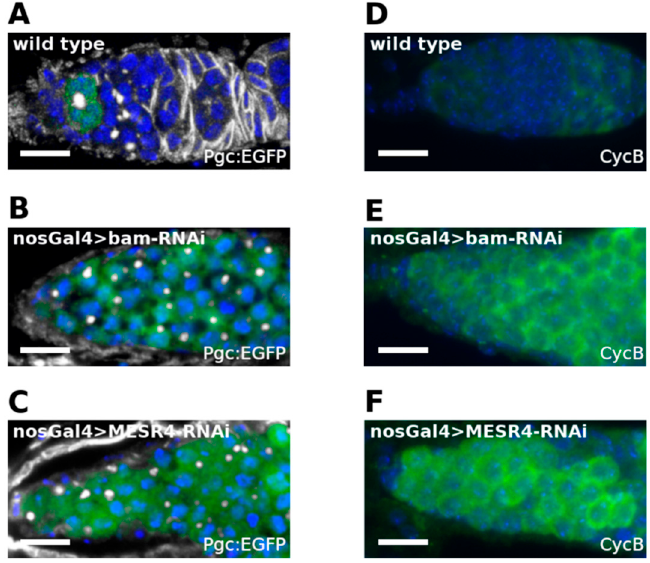
Figure 4. Analysis of pre-CB specific molecular markers of MESR4-silenced germ cells. ( A – C ) Immunostaining of niches expressing Pgc:EGFP. Wild type ( A ), nosGal4 > MESR4 -RNAi ( B ) and nosGal4 > bam -RNAi niches are stained with GFP (green), HTS (white) and DAPI (blue). Niches silenced for MESR4 or bam accumulate a high number of Pgc-positive pre-CBs. ( D – F ) Immunostaining of niches with CycB (green) and DAPI (blue). Wild type niche ( D ). NosGal4 > bam -RNAi ( E ) and nosGal4 > MESR4 -RNAi ( F ) niches accumulate a high number of CycB positive cells.